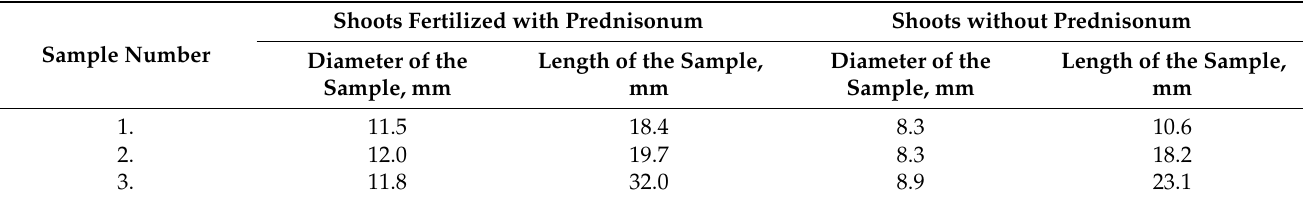
Table 3. Physical characteristics of prepared samples.